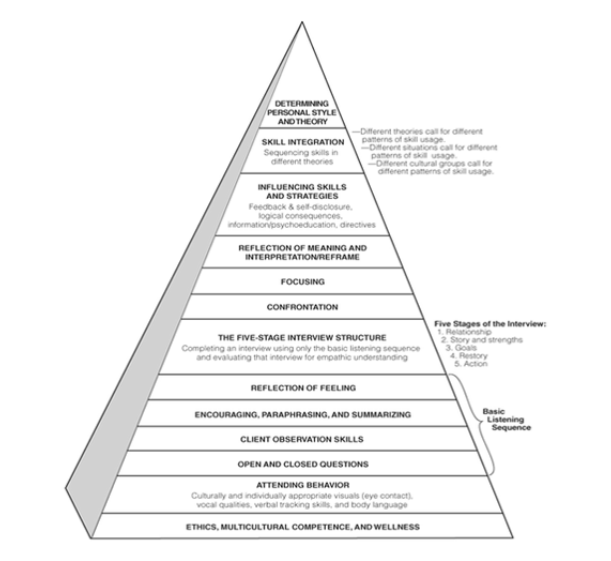
Figure 8. The Microskills Pyramid